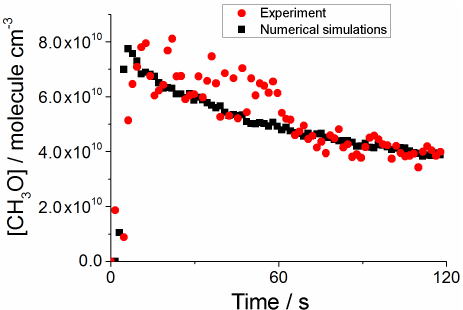
Figure 8. Concentration of CH 3 O as a function of time in HIRAC: red points are the experimental data and black points are gener- ated by a numerical simulation. CH 3 O radicals were formed as a product of the self-reaction of CH 3 O 2 species at 295K and 1bar of N 2 , with CH 3 O 2 generated by the reaction of Cl atoms with CH 4 , and with the HIRAC black lamps being turned on at time zero. Oxygen was present in trace amounts, determined to be (5.4 ± 0.6) × 10 15 moleculecm − 3 from comparison of the simula- tions to the experimental data. The chemical mechanism used in the numerical simulations is presented in the